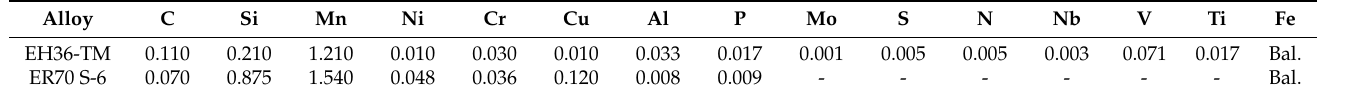
Figure 1. Dimensions of the plates to be butt welded on T-joint: ( a ) overview, ( b ) side view, unit: mm. Table 2. Chemical compositions of base material and filler wire (wt %).